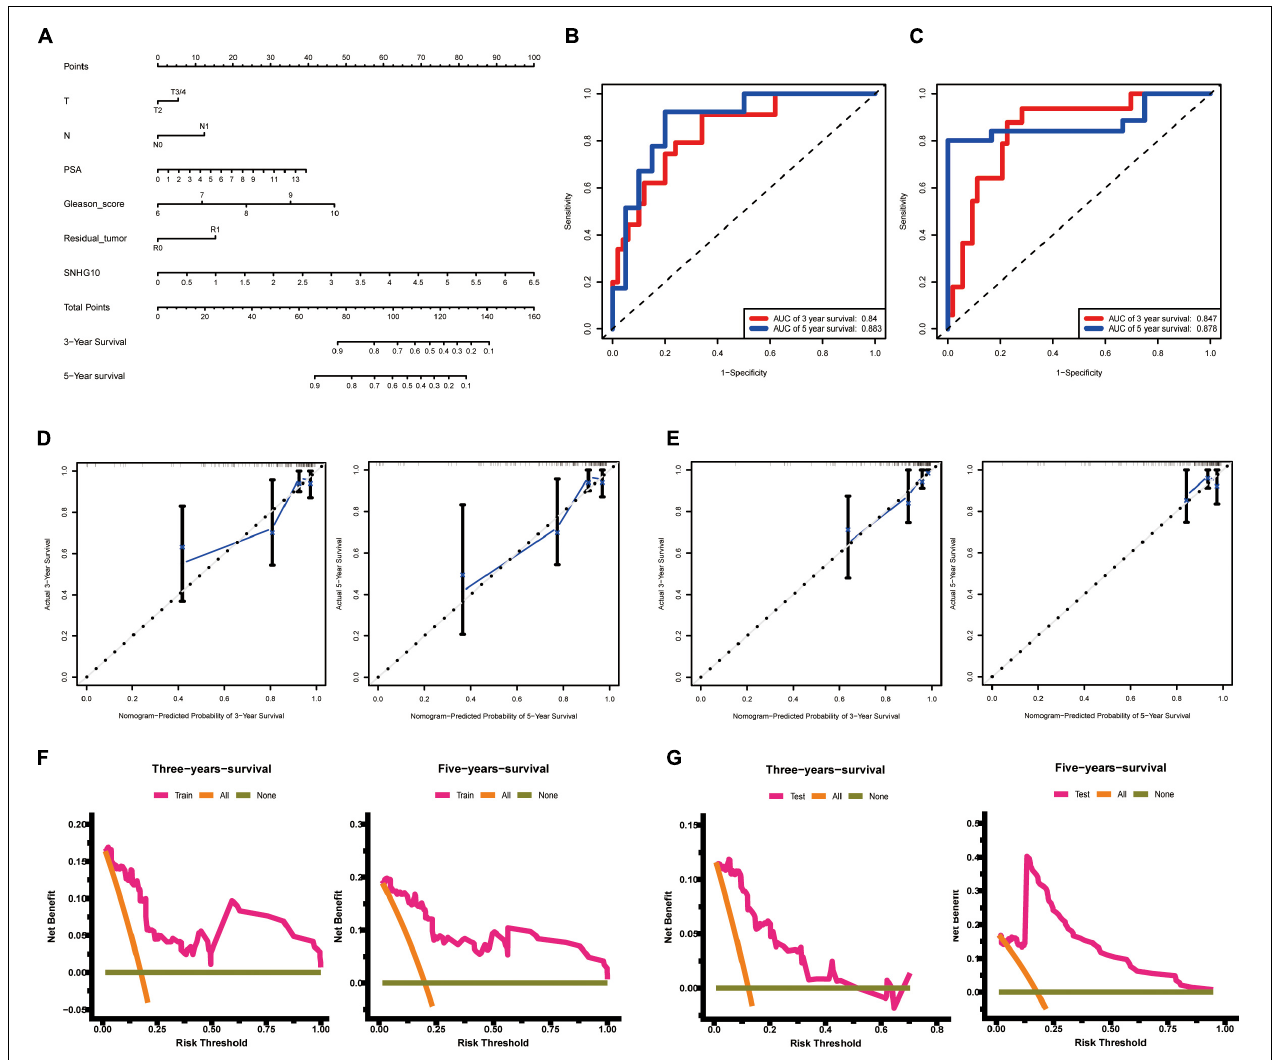
FIGURE 5 | Construction and validation of the nomogram. (A) The nomogram for predicting 3-year and 5-year PFS of PC patients. The nomogram AUC of values for 3-year and 5-year PFS (B) in the training cohort and (C) the test cohort. The calibration plots (D) in the training cohorts and (E) the test cohorts. DCA curves (F) in the training cohorts and (G) the test cohorts. ROC, receiver operating characteristic; AUC, area under the ROC curve; DCA, decision curves